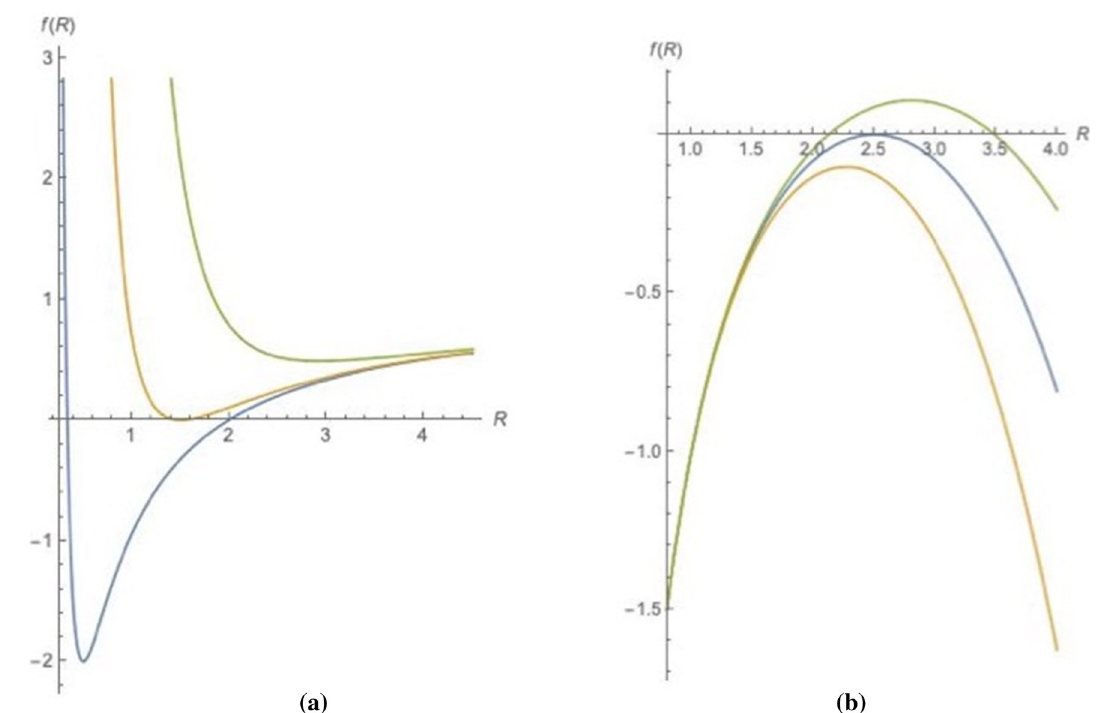
Fig. 1 A The left graph contains three curves for ω > 0 and λ <